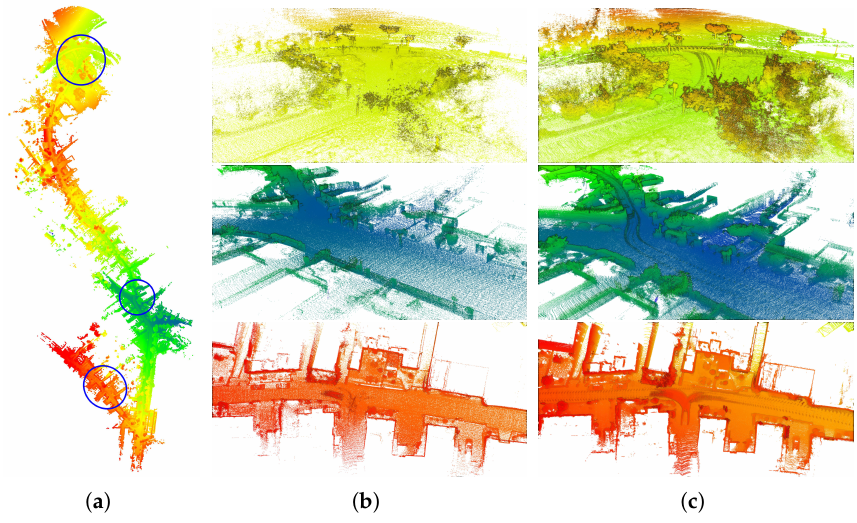
Figure 17. InTEn-LOAM’s map result on country scenario (KITTI seq.10): ( a ) overview, ( b ) map in detail of circled areas, ( c ) reference map